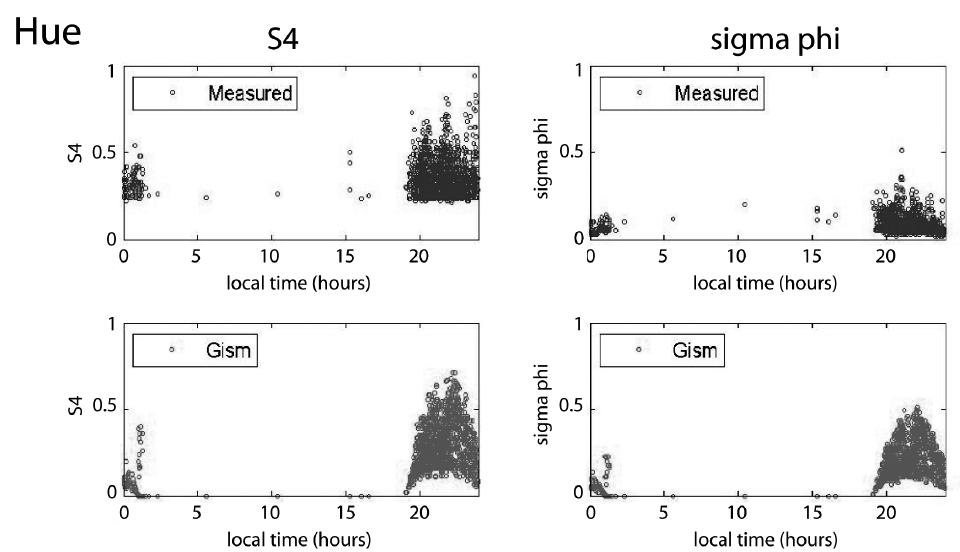
Fig. 7. Model-measurements comparisons (PRIS measurement campaign 2006-2007).